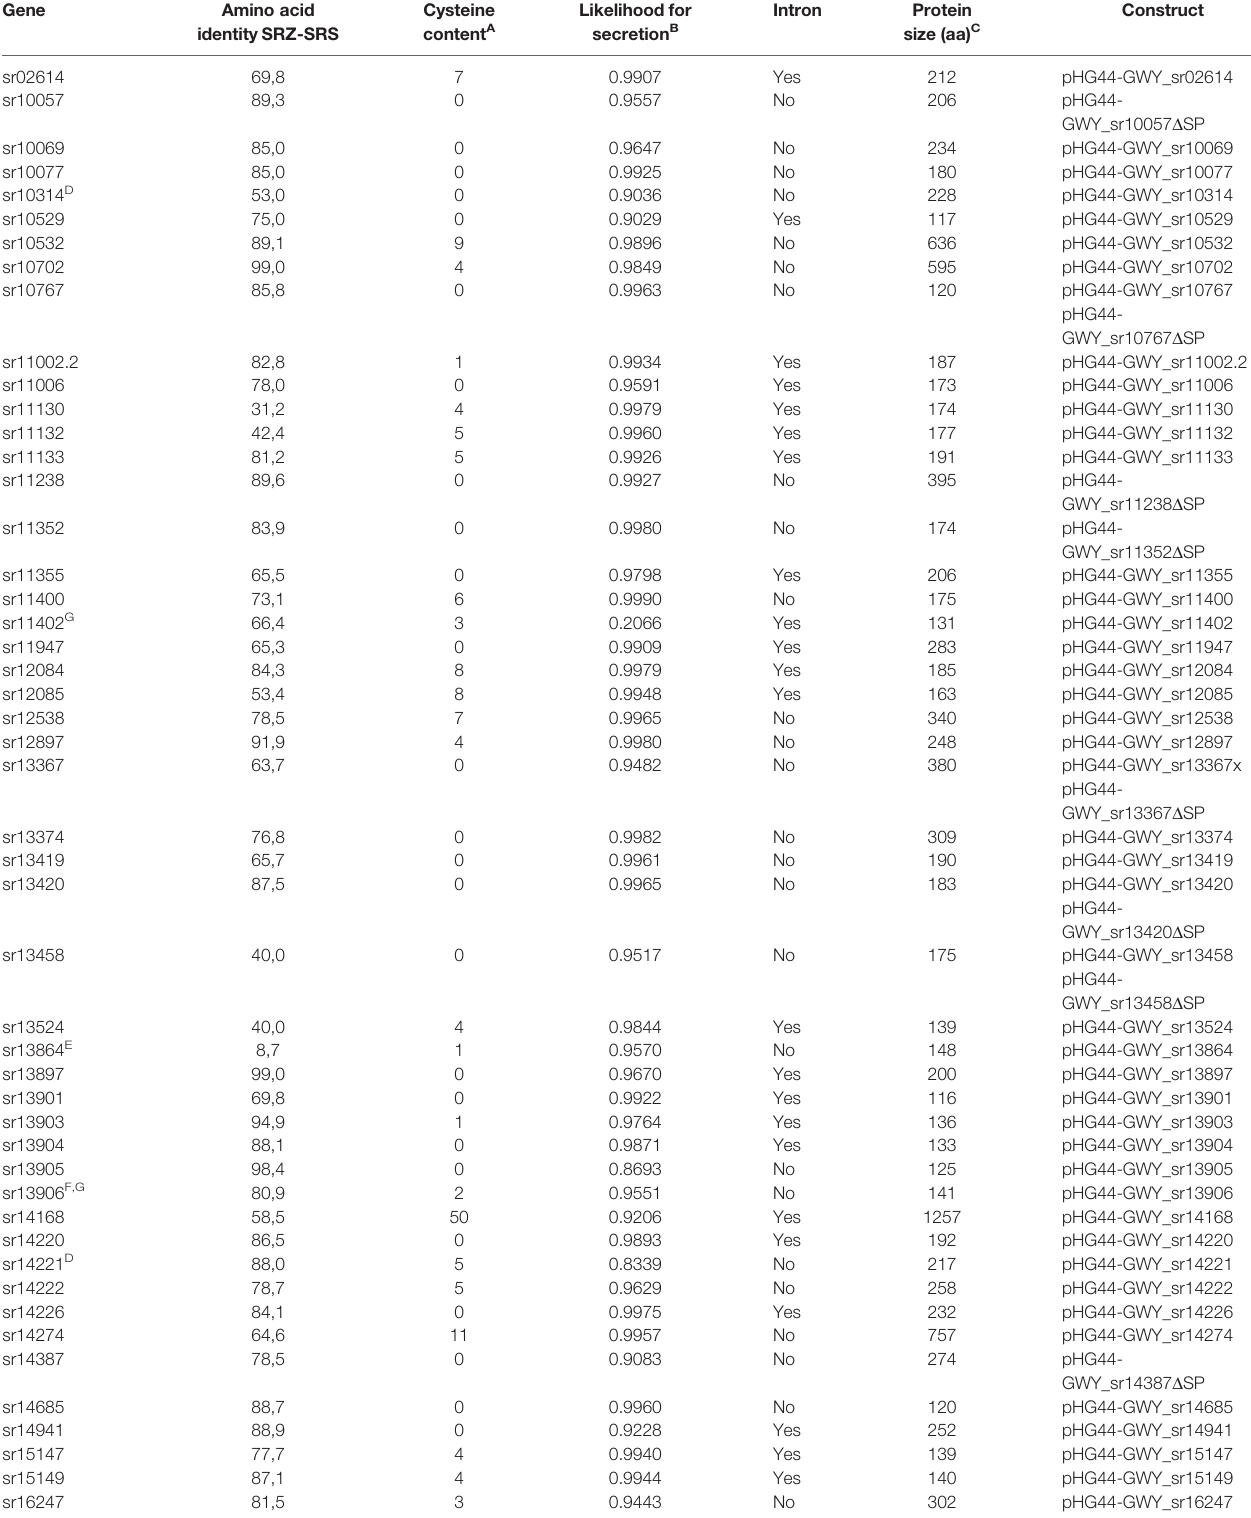
TABLE 1 | SRZ genes selected to be tested for programmed cell death (PCD) suppression in N. benthamiana in this study. Fifty-six effector candidates were cloned from genomic DNA, some of them carry introns. Gene